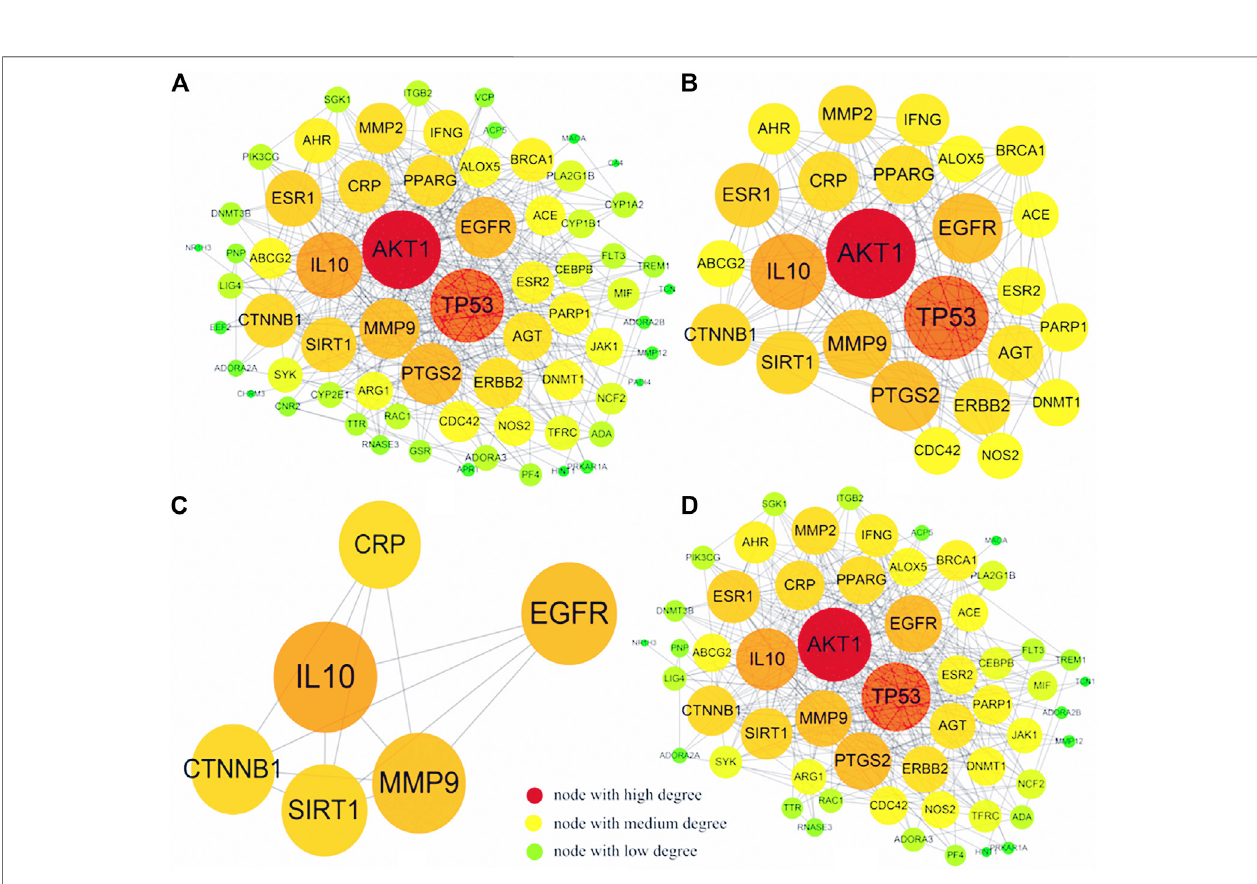
FIGURE8| T-Dnetworkdiagram. (A) isthegraphaftertheisolatednodesandconnectededgesarededucted, (B) istherelevantinformationgraphafterextracting themeanvaluegreater thanadegree(11.463), (C) isthegraph ofsixcoretargets, (D) isthesixcoretargetsThecore targetnetworkoftheremainingconnectingnodes.